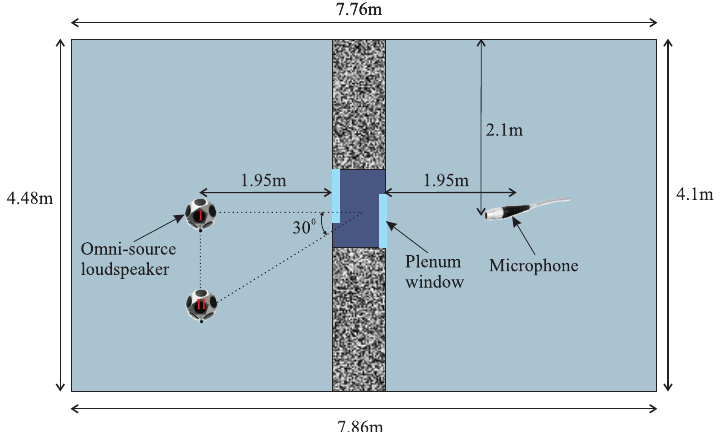
Figure 3. Experimental set-up of experiments I and II (schematic diagram, top view, without perforated thin